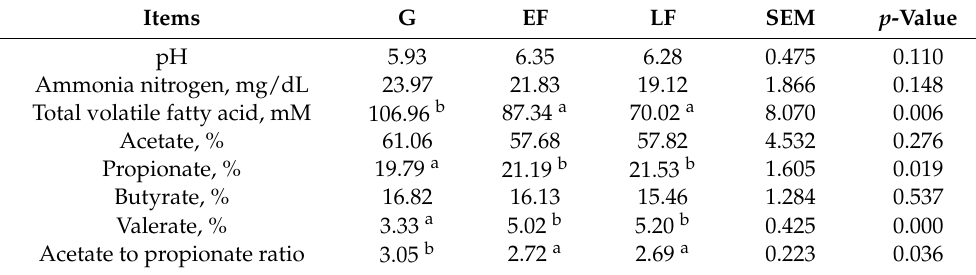
Table 3. Comparison of rumen fermentation according to different growth stages.